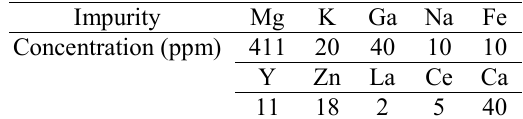
Table 2. Alpha alumina impurity determined by ICP-MS